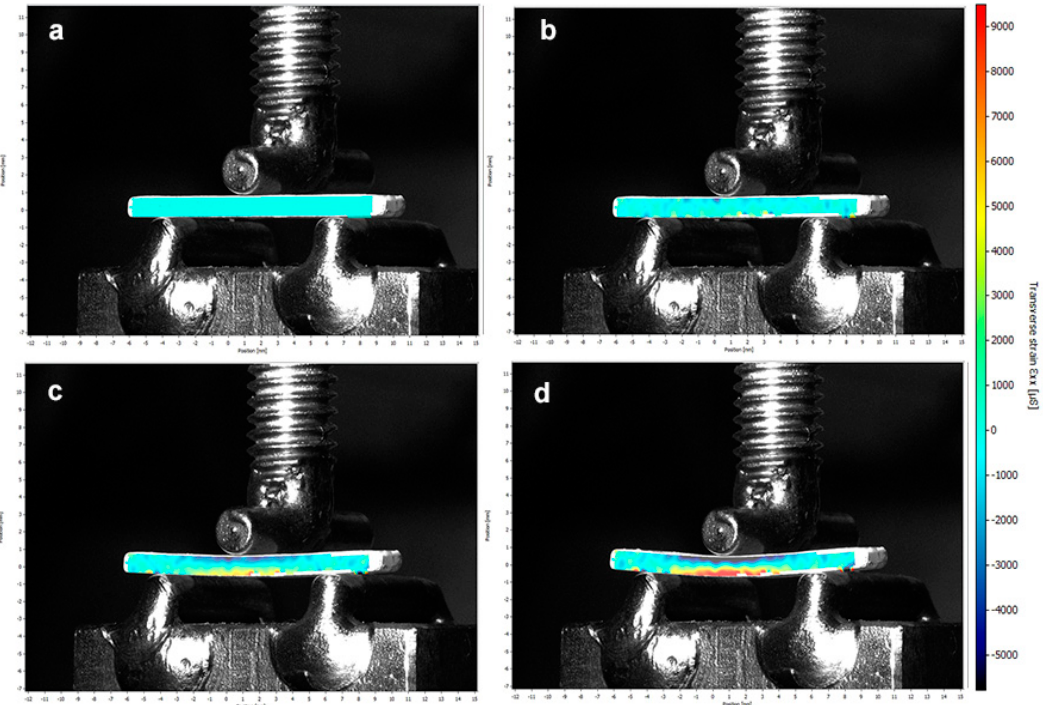
Figure 4. The sequence of photographs obtained in the DIC analysis of the material AH: ( a ) without strain concentration; ( b ) when the test starts; ( c ) with more load on specimen the strain concentration increases; and ( d ) the last photograph before failure.